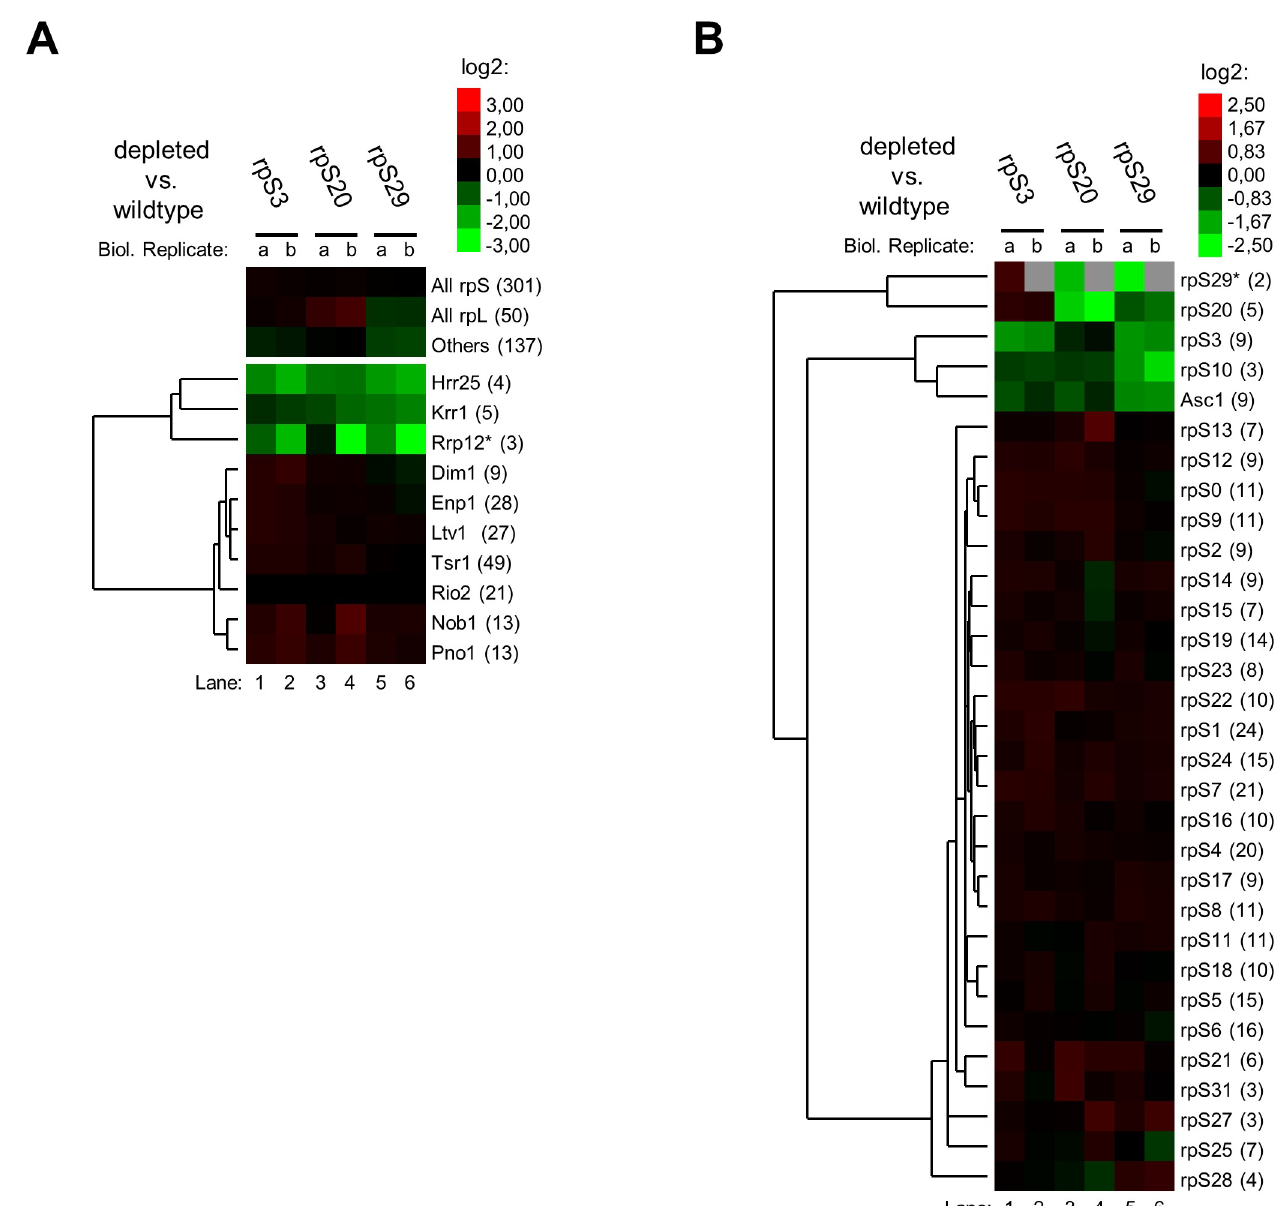
Fig 4. Semi-quantitative proteomic analyses of changes in the Rio2 associated SSU precursor protein composition after in vivo depletion of S3-cluster proteins. Yeast strains were cultivated for four hours in glucose containing medium to shut down expression of either rpS3 (Y427), rpS20 (Y428), rpS29 (Y2705) or no r-protein (Y409). SSU precursors associated with TAP tagged Rio2 were affinity purified and the SSU precursor protein composition of each conditional expression mutant was compared with the one of wildtype cells (depleted vs. wildtype) by semi-quantitative mass spectrometry as described in Materials and Methods. The results of two independent biological replicates (a, b) for ribosome biogenesis factors (A) and for SSU r-proteins (B) are visualized as heat map (colour legend in the upper right corner). Trees on the left of the heatmaps show results of hierarchical clustering analyses to identify groups of proteins with similar changes (see Materials and Methods). The respective names of proteins are indicated on the right of the heatmaps with the average number of peptides identified for each protein in brackets. A star ( � ) indicates that the respective protein was identified in one of the analyses just by one